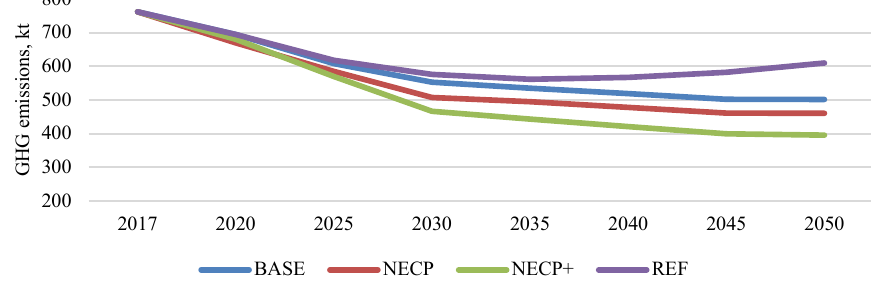
Fig. 11. GHG emissions in industry sector in the modelled